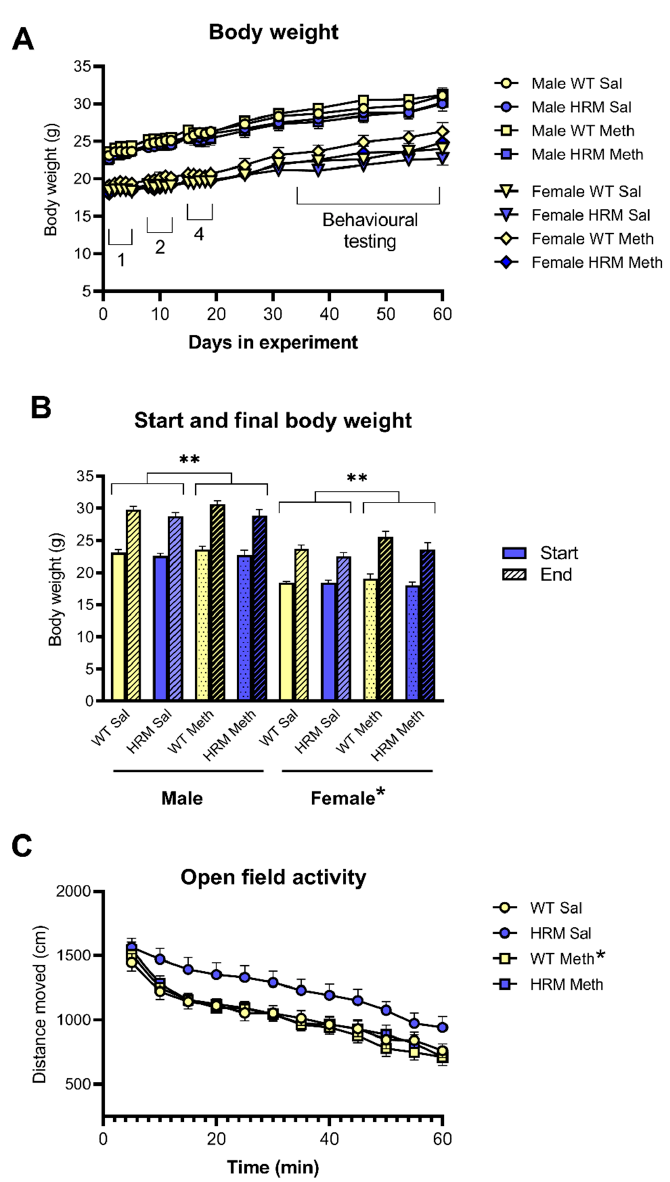
Figure 1. Body weight and spontaneous exploratory locomotor activity of male and female WT and HRM treated chronically with saline or Meth. Panel A shows body weights during the entire experiment, including treatment with 1 mg / kg (1), 2 mg / kg (2) and 4 mg / kg (4) starting from 6 weeks of age. Behavioural testing was done starting two weeks after the last injection. Panel B shows start and end body weight of all groups. * p < 0.05 for lower body weights in female mice compared to male mice. ** p < 0.05 for lower body weight gain in HRM compared to WT independent of Meth treatment or Sex. Panel C shows spontaneous exploratory locomotor activity expressed as distance moved every 5 min before injection of challenge saline or Meth. Data were combined for male and female groups of WT and HRM which were pretreated with saline or Meth. * p < 0.05 for higher activity in HRM-pretreated with saline compared to the other groups. Exploratory activity habituated over the one-hour period but there were no other differences between the groups.